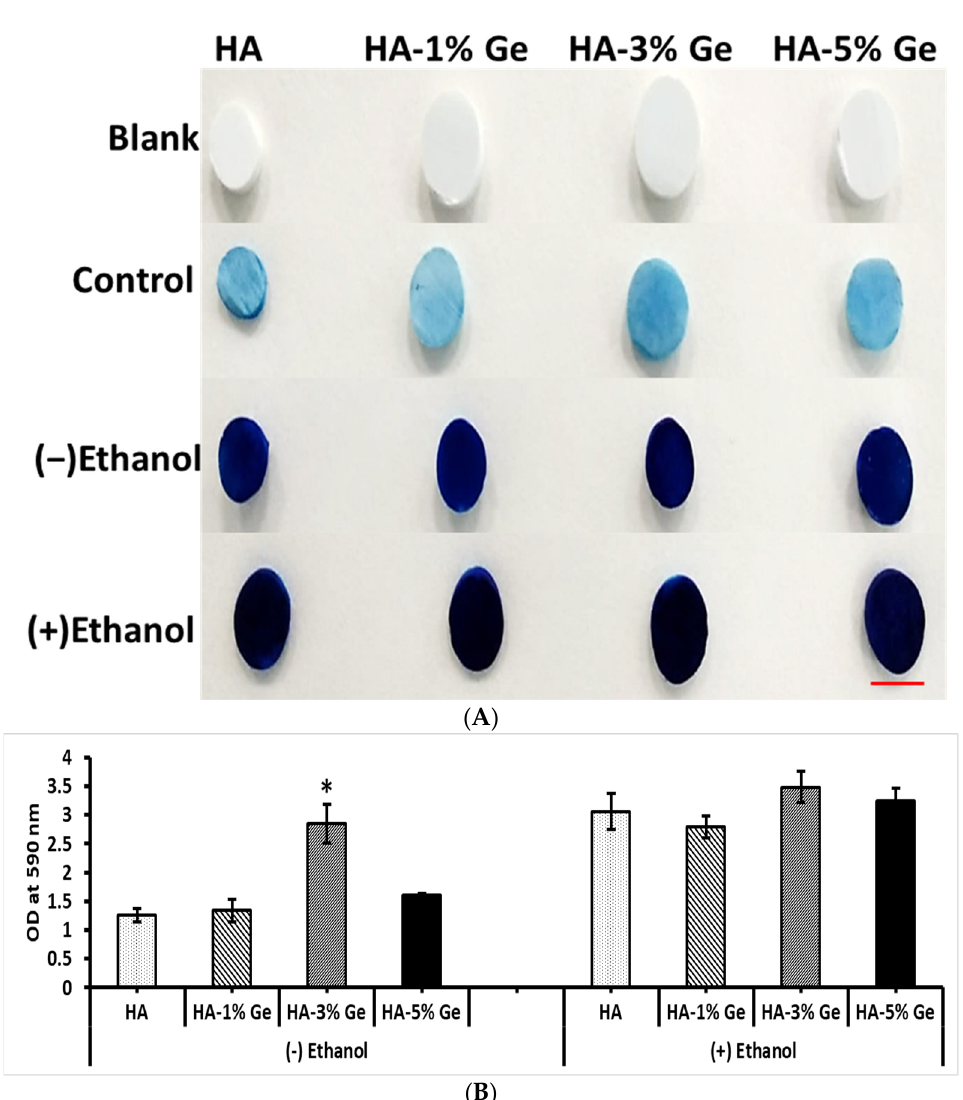
Figure 7. Protein absorption ability of HA-Ge biomaterials by CBB test. ( A ) CBB stained HA-Ge composites, Scale bar—1 cm, ( B ) Intensity of CBB staining in HA-Ge composites by UV absorption at 590 nm. Blank—samples without any treatment, control—FBS untreated samples with CBB stain, ( − ) Ethanol: HA-Ge composites without ethanol treatment and (+) Ethanol: HA-Ge composites with ethanol treatment. HA-control, HA-1%Ge-HA with 1% germanium, HA-3%Ge-HA with 3% germanium and HA-5%Ge-HA with 5% germanium. The UV absorption of control (2nd row in image ( A )) was below the measurable range. * denotes statistical significance, p < 0.05 vs. HA.